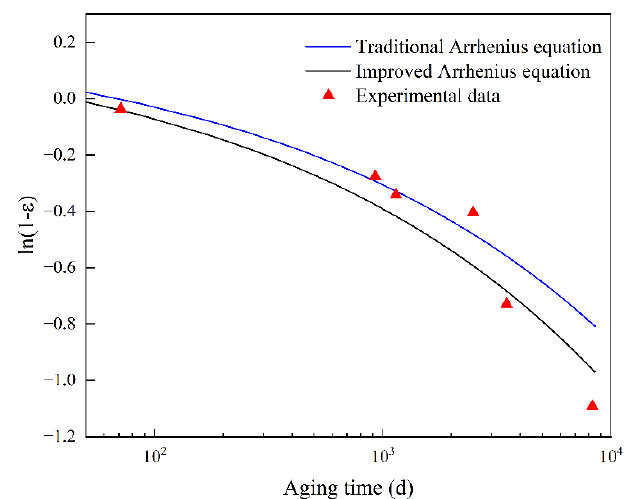
Figure 5. Comparison of traditional and improved Arrhenius equations in fitting experimental data. Table 4. Comparison of life prediction results between traditional and improved Arrhenius equa- tion.